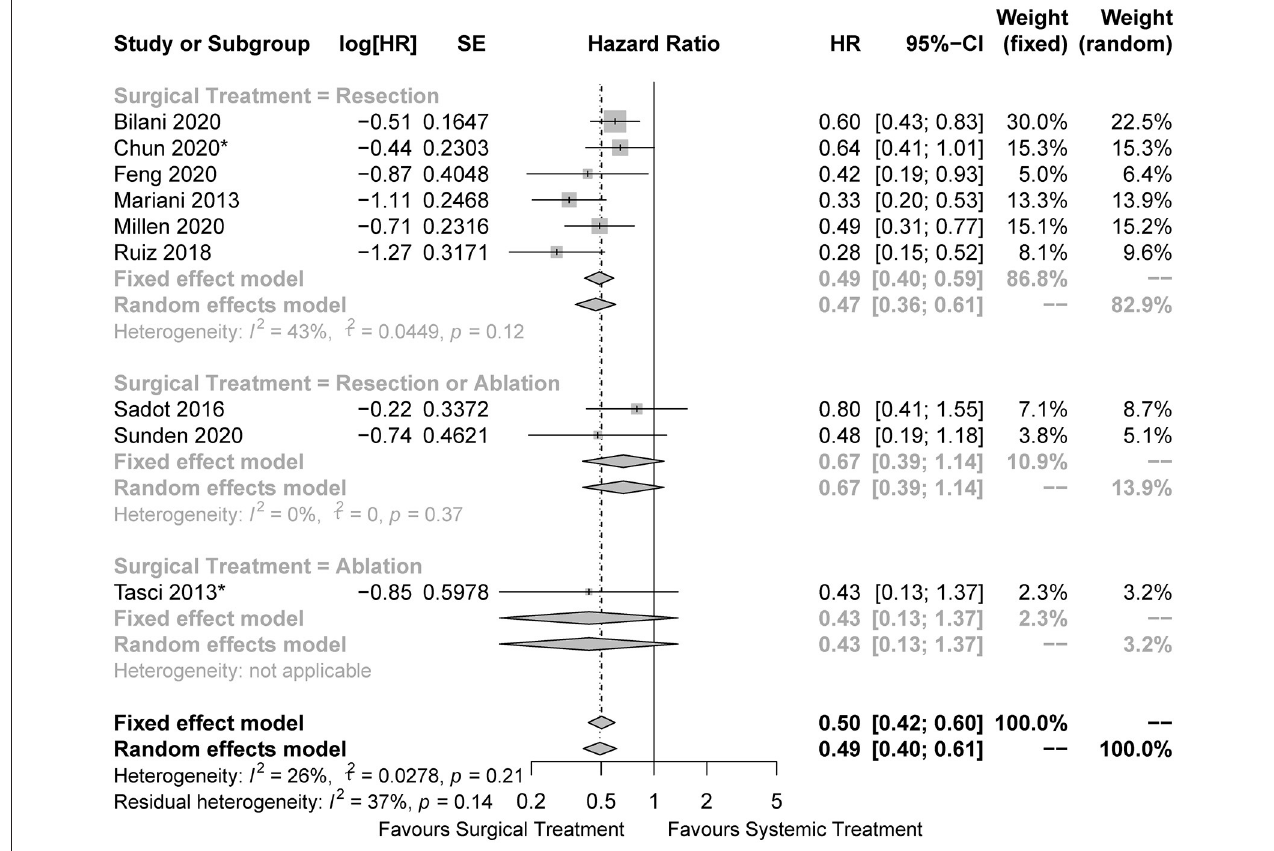
FIGURE 2 | Forest plots for comparison of overall survival between surgical and systemic cohorts in all included studies. The HRs of the matched cohorts were incorporated when the studies also reported the results before matching. *The hazard ratio was estimated from the survival curves.